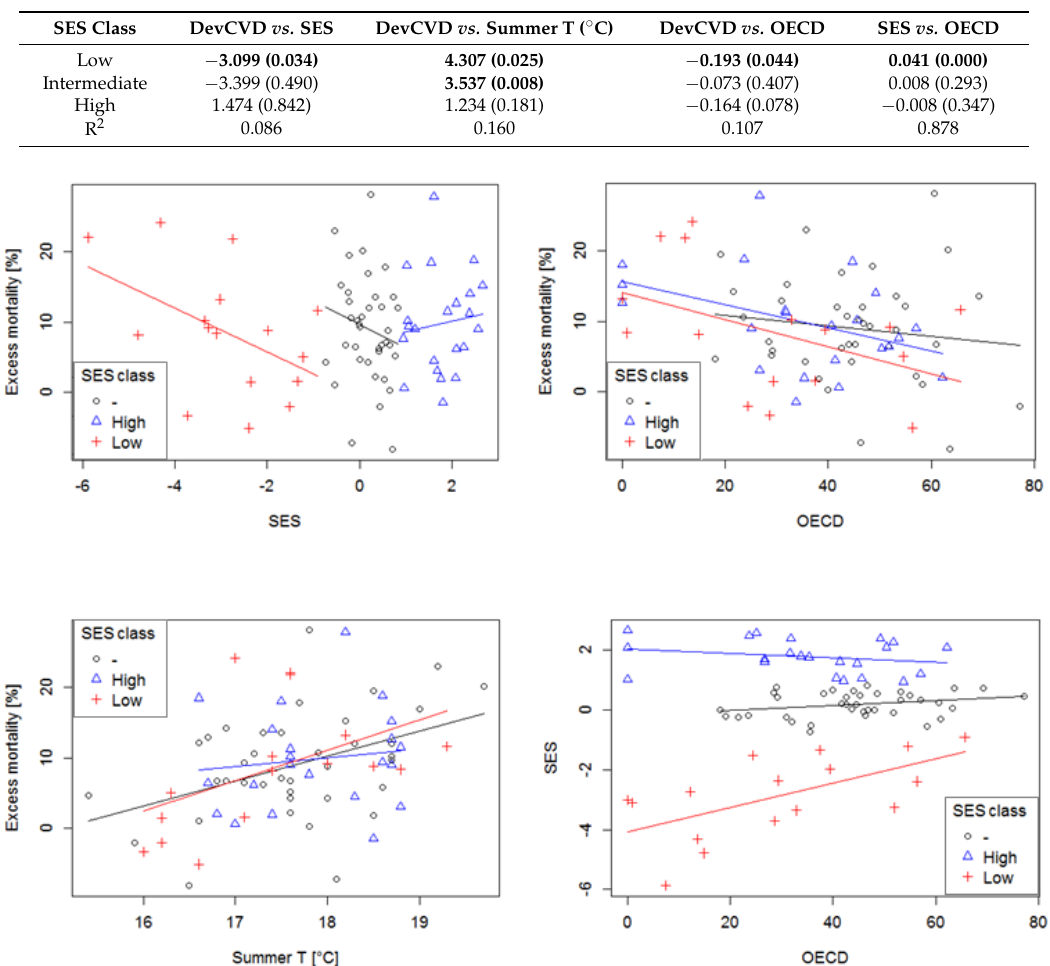
Table 5. Linear regression models for mean relative excess mortality due to CVDs on hot days ( DevCVD ) against index of socioeconomic status ( SES ), percentage of rural population ( OECD criterion), and mean summer temperature ( Summer T ) for districts with low , intermediate , and high socioeconomic status ( SES class). Regression coefficients are reported, along with their associated p -values in parentheses. See Table 1 for description of variables examined. Significant regression coefficients with p -value < 0.05 are in bold.